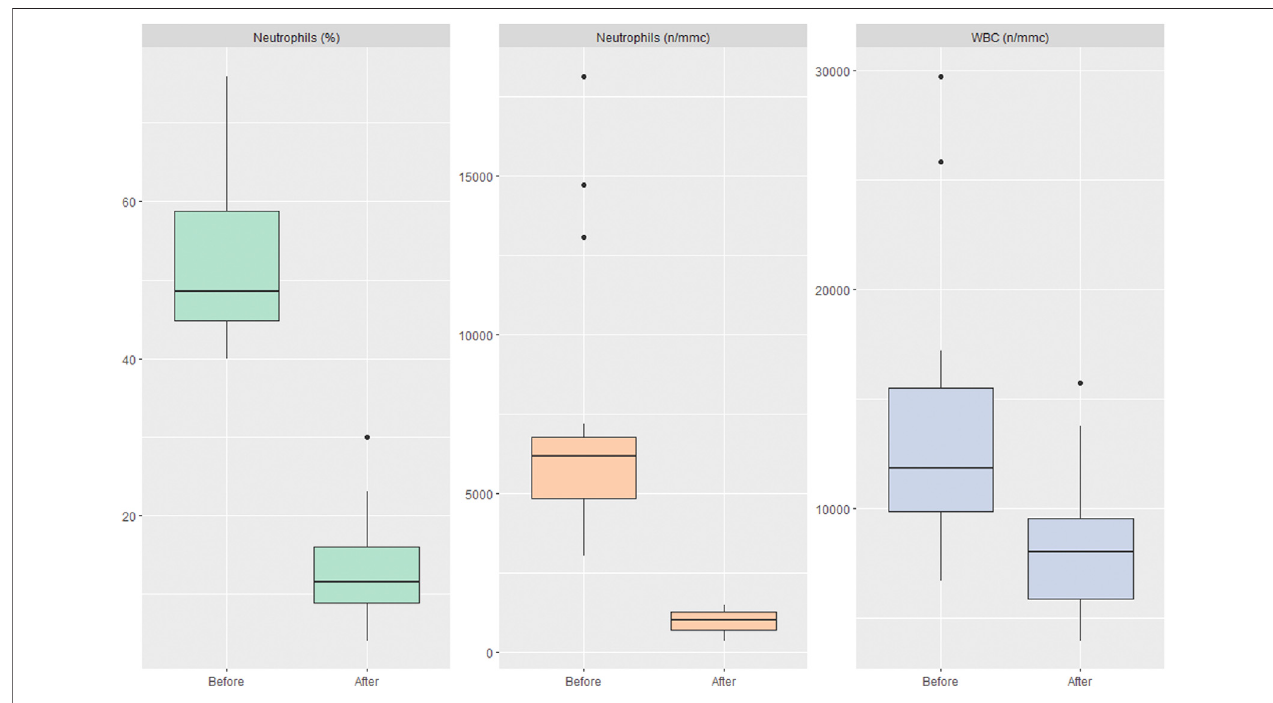
FIGURE 1 | The median of the pre-and post-therapy neutrophils (%, n/mmc) and WBC levels (n/mmc).